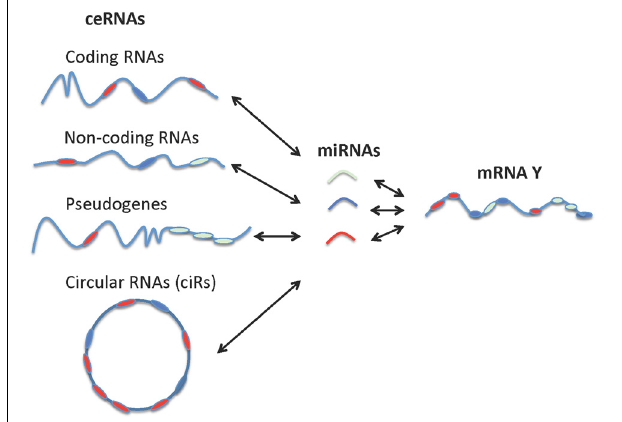
FIGURE 3 | Interactions between different types of ceRNAs, miRNA, and mRNA. Coding RNAs and non-coding RNAs including pseudogenes, lncRNAs, and circular RNAs can function as